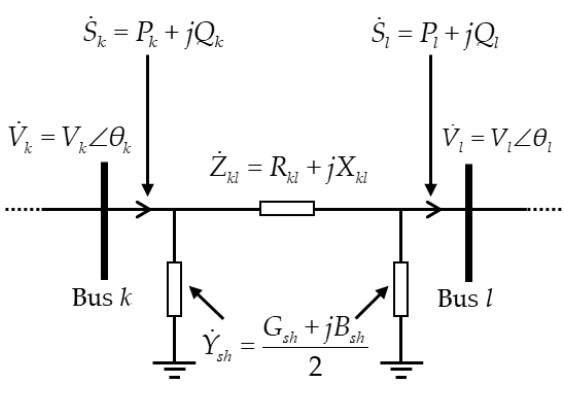
Figure 1. Transmission line model.